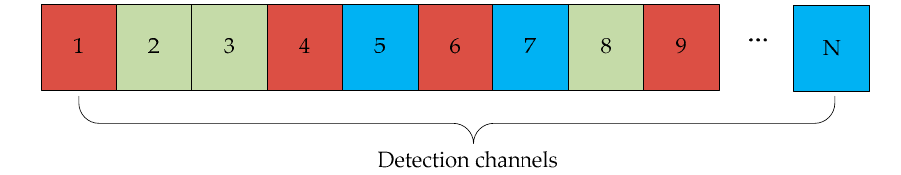
Figure 1. Conventional method for wideband spectrum sensing.